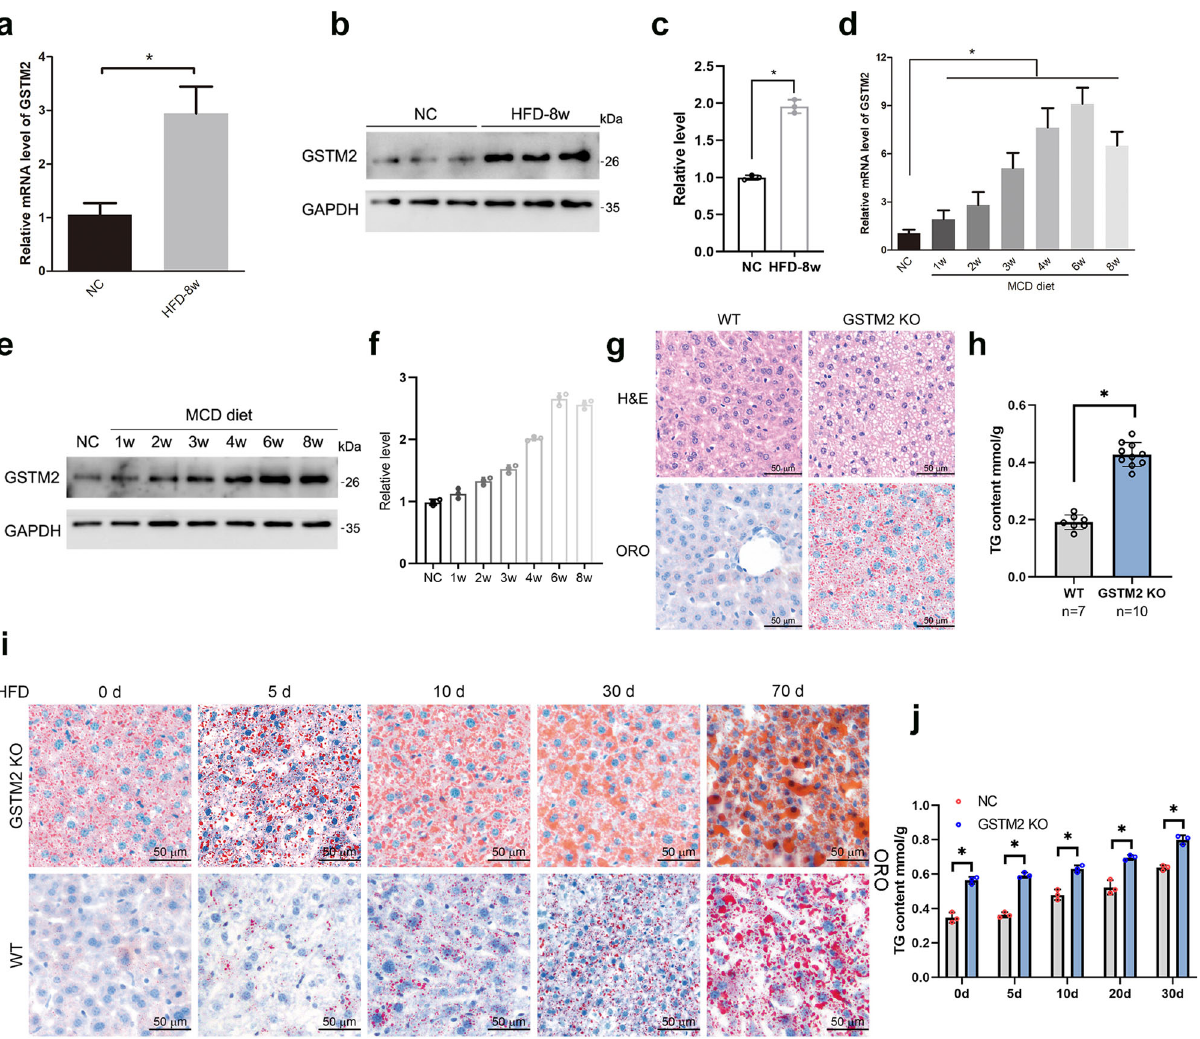
Fig. 1 Loss-of-function of GSTM2 promoted hepatic fat storage. a – c GSTM2 mRNA and protein expression in liver samples of 8-week HFD fed mice ( n = 3) and 8-week chow diet fed mice ( n = 3); * p < 0.05. d – f GSTM2 mRNA and protein expression in liver samples of MCDD fed mice and corresponding control mice; * p < 0.05. GAPDH served as the reference gene. g Haematoxylin and eosin (HE) and Oil red O staining analysis of liver samples of GSTM2 knockout (KO) and control mice; bar = 20 μ m. h Hepatic TG concentrations of WT ( n = 7) and GSTM2 KO ( n = 10) mice were detected; *** p < 0.001. i Oil red O analysis of liver samples of GSTM2 KO and control mice challenged with HFD at 0 d, 5 d, 10 d, 20 d, and 30 d. j Hepatic TG concentrations of WT and GSTM2 KO mice with high-fat diet treatment at 0 d, 5 d, 10 d, 20 d, and 30 d; * p < 0.05. bar, 50